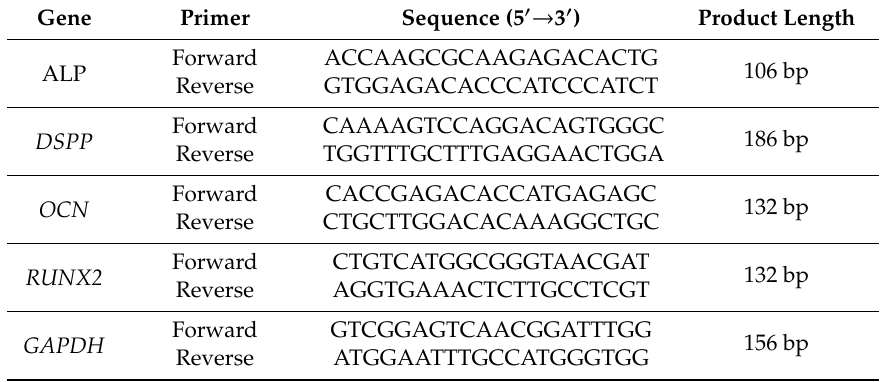
Table 1. Sense and antisense primers used for